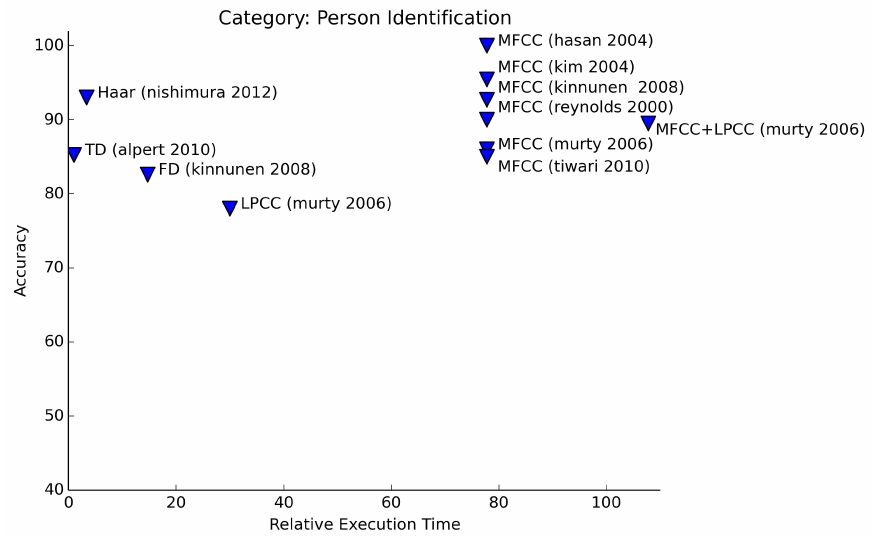
Figure 9. Relative execution time for person